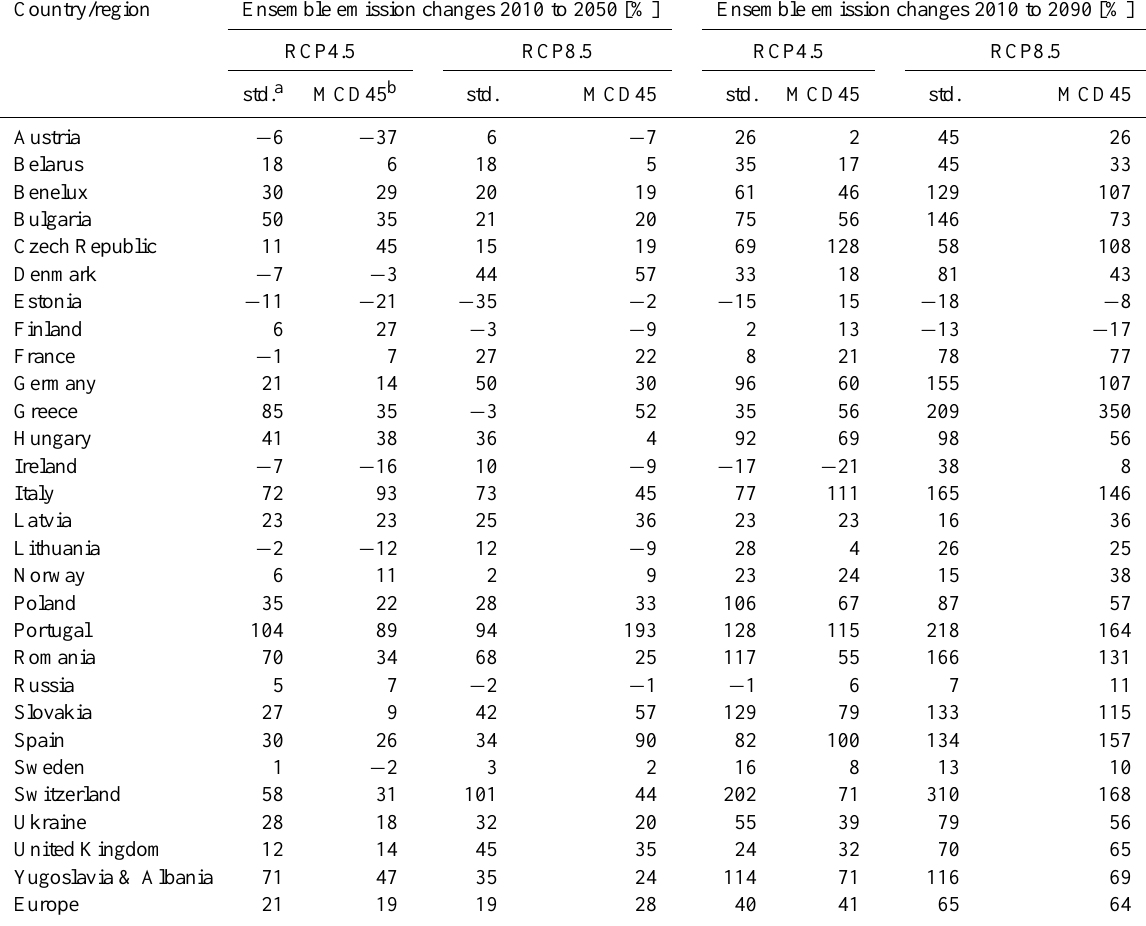
Table A1. Sensitivity of predicted emission changes to SIMFIRE